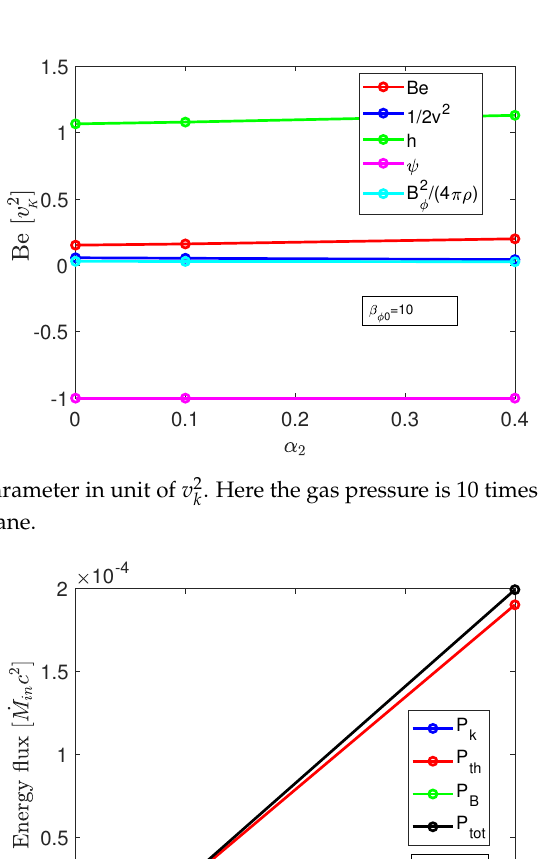
Figure 8. Energy fluxes carried by outflow. Here the gas pressure is 10 times larger than the magnetic pressure at the